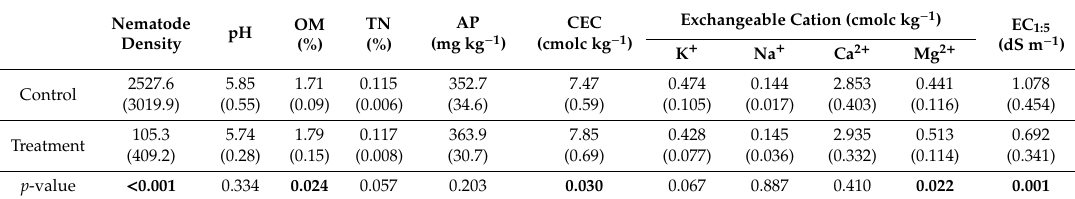
Table 1. Soil nematode density and chemical properties after soil fumigation treatment in the open-field nursery.